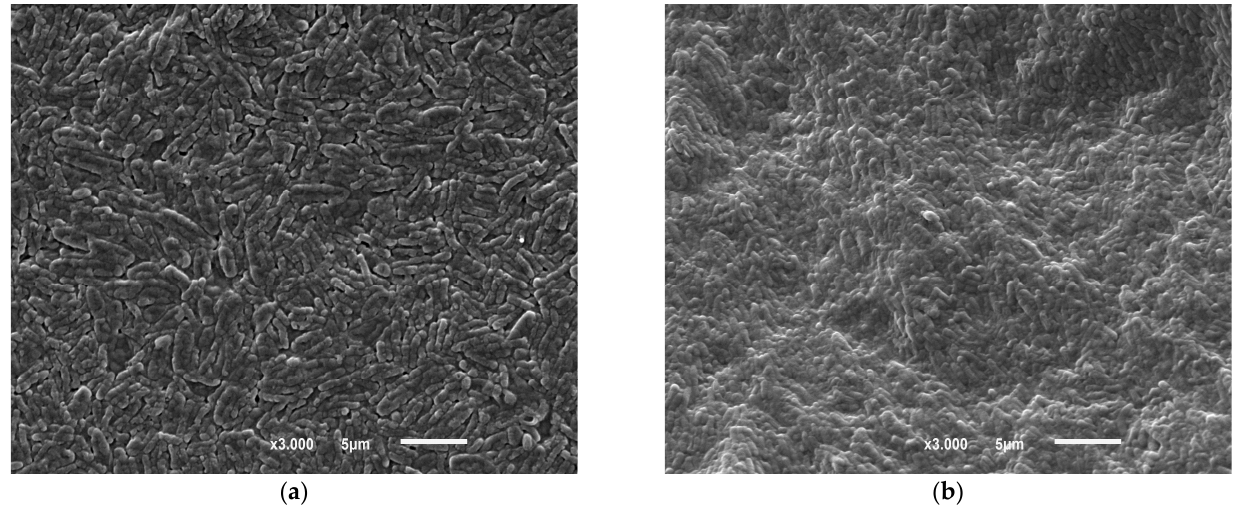
Figure 11. SEM analysis of Bacillus megaterium surface ( a ) before and ( b ) after Cr 6+ biosorption.